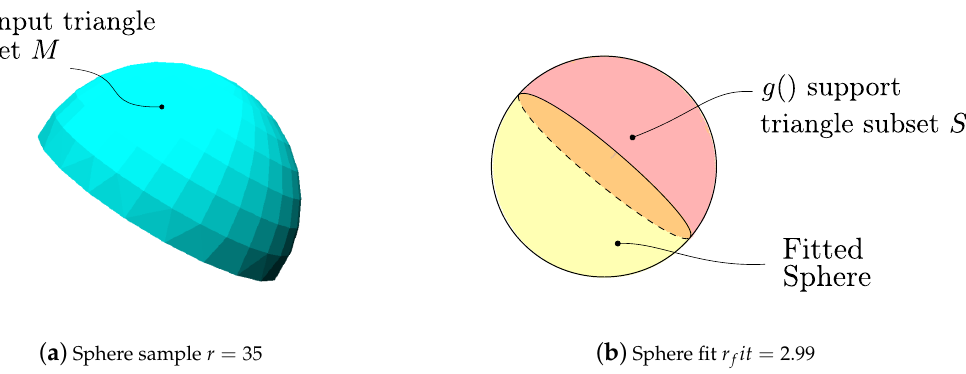
Figure 23. Sphere fitting using dihedral angle-based extraction. Pink: segmented sphere. Yellow: fitted sphere. Notice that S = M .